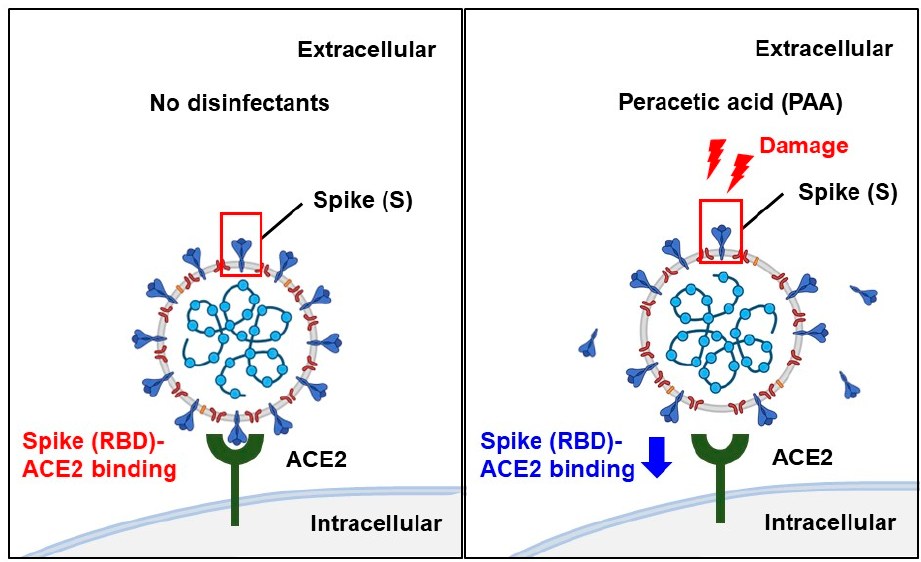
Figure 6. Scheme of disinfection effects of PAA against SARS-CoV-2. PAA is effective against a wide range of pathogens; it generates hydroxyl radicals, which cleave the Cys480-488 disulfide pair in the SARS-CoV-2 spike RBD and break the disulfide bond in the spike protein. As a result, it reduces the abundance of intact spike proteins and reduces the binding of the SARS-CoV-2 spike RBD to its host cell receptor, ACE2. PAA exhibits disinfection effects by inhibiting SARS-CoV-2 spike protein-mediated entry into the host cells. Schemas were created using BioRender.com.